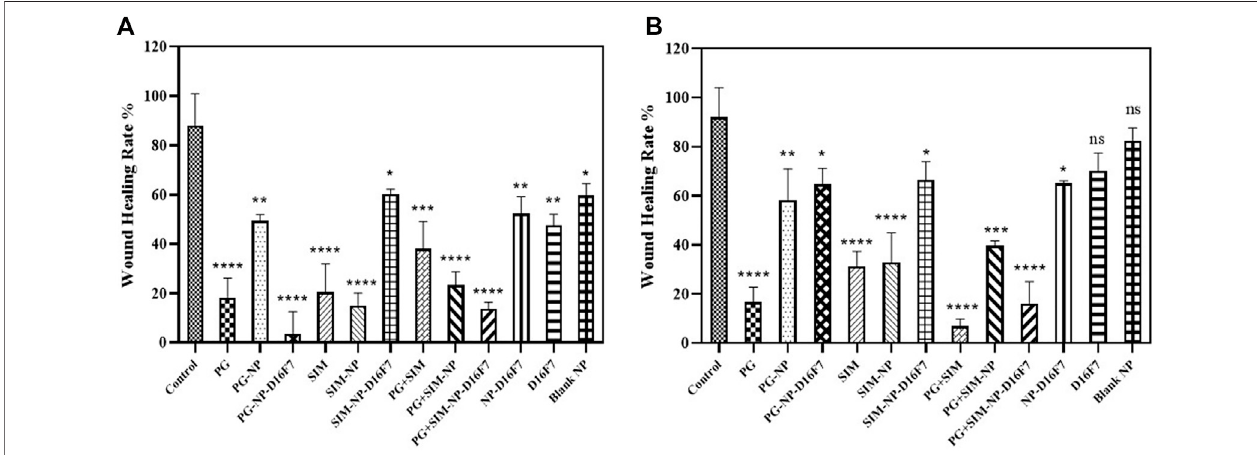
FIGURE6| Comparative evaluationofthepercentage ofwound healingofdifferent drugformulationsat 24 h (A) and 48 h (B) onMCF-7 cell line.Signi fi cance was de fi ned for p <